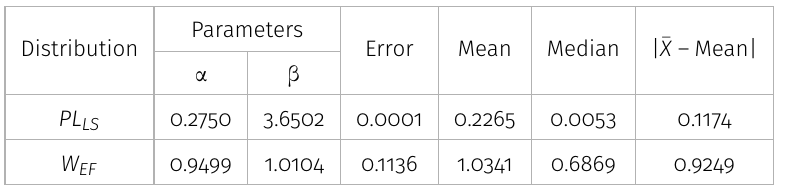
Table IV. NOC in system category.